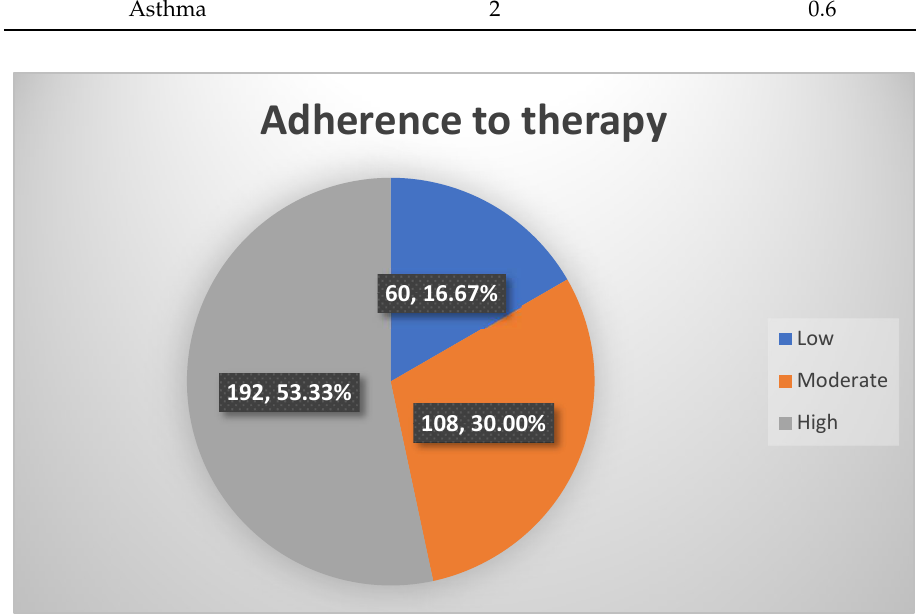
Figure 1. Adherence to anti-retroviral therapy.